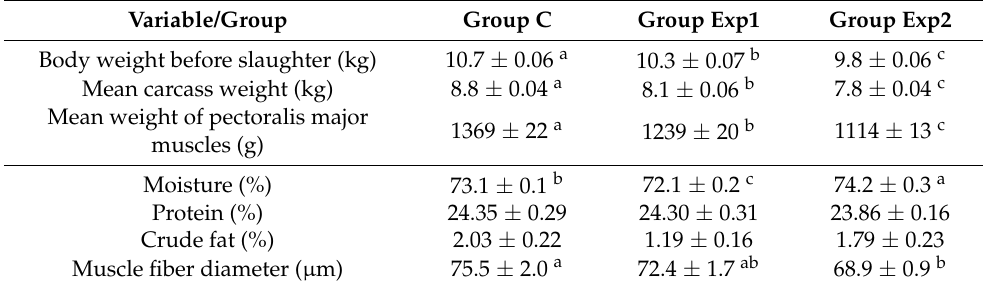
Table 4. Mean ( ± SEM) body and carcass weight, proximate chemical composition, and muscle fiber diameter of pectoralis major muscles in organic turkeys receiving three different diets.